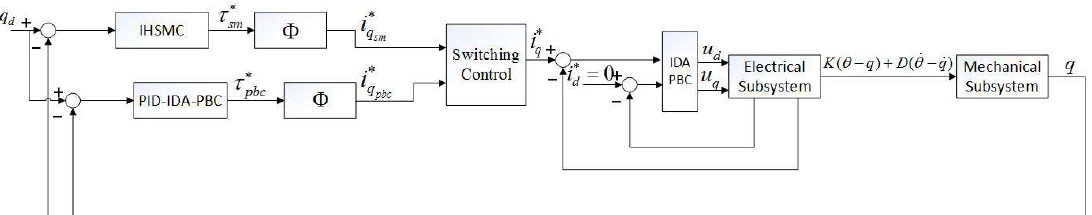
Figure 1. The figure of the hybrid control